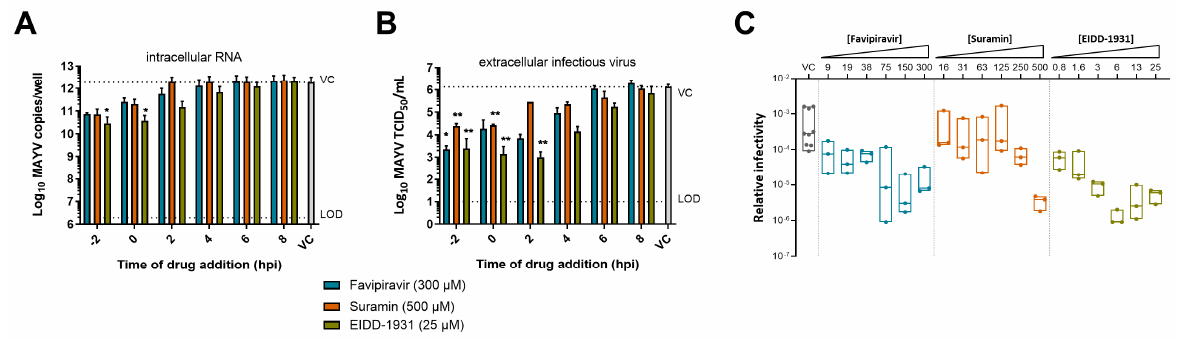
Figure 3. Mechanism of action of EIDD-1931, favipiravir and suramin against MAYV. Delay of treatment effect of favipiravir (blue), suramin (orange) and EIDD-1931 (green) on ( A ) intracellular RNA and ( B ) infectious virus titers, determined at 10 h pi, using qRT-PCR and end-point titrations, respectively. Vero cells were infected with MAYV TC625 (MOI 1) and compounds were added 2 h prior to infection ( − 2), at the time of infection (0) or 2, 4, 6, 8 h pi. Data shown are mean values ± SD from three (favipiravir and suramin) or four (EIDD-1931) experiments. Significant differences from untreated virus control were analyzed by Kruskal–Wallis test (*, p < 0.05; **, p < 0.005). ( C ) Relative infectivity (i.e., the ratio infectious virus: viral RNA) of MAYV in the supernatant in the presence of different compound concentrations. Data are presented as floating bars showing median values of three virus yield experiments. TCID, tissue culture infectious dose; VC, virus control (untreated); hpi, hours post infection; LOD, limit of